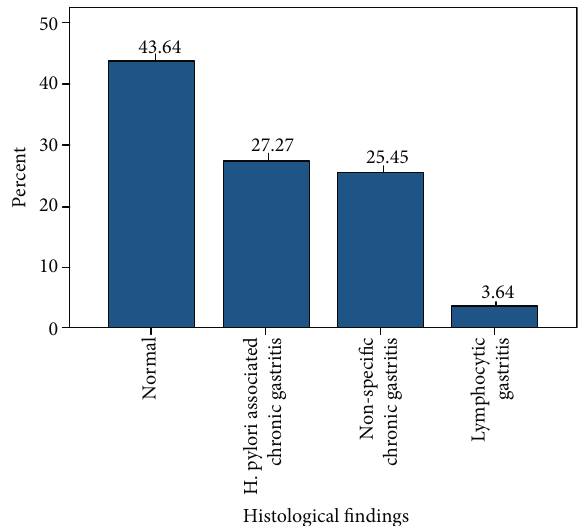
Figure 5: Histological fi ndings in patients with normal study on